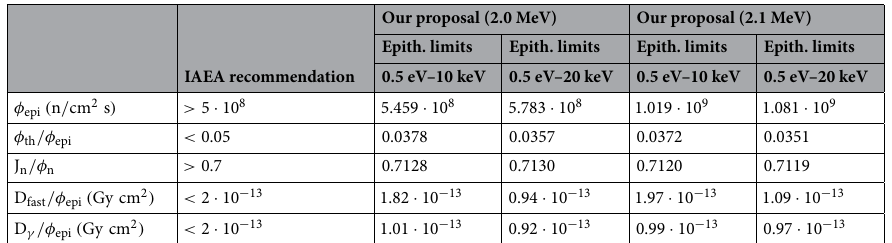
Table 2. In-air beam parameters compared to the IAEA recommendations, for proton accelerator energies of 2.0 and 2.1 MeV. The results considering the epithermal upper limit at 10 and 20 keV are